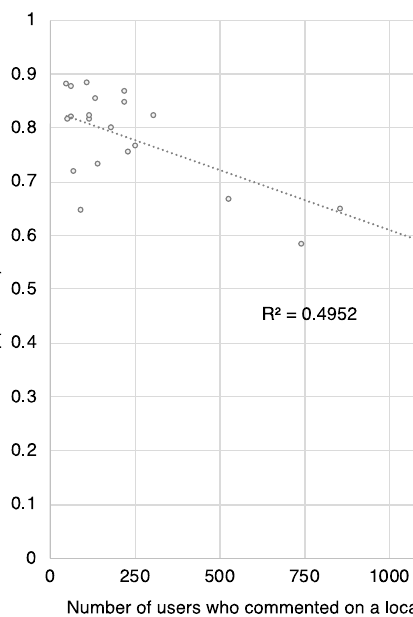
Table 1. Cross ‐ tabulation of Qyer users based on their number of followers F i and their number of reviewed places R i .